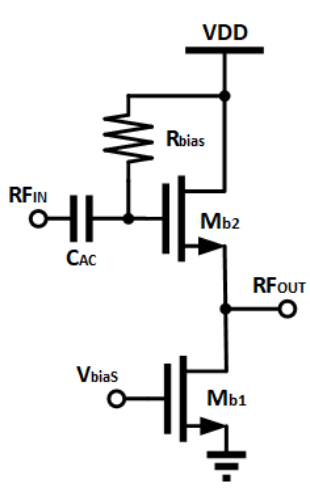
Figure 2. Schematic of the source follower output buffer. Table 1. Device